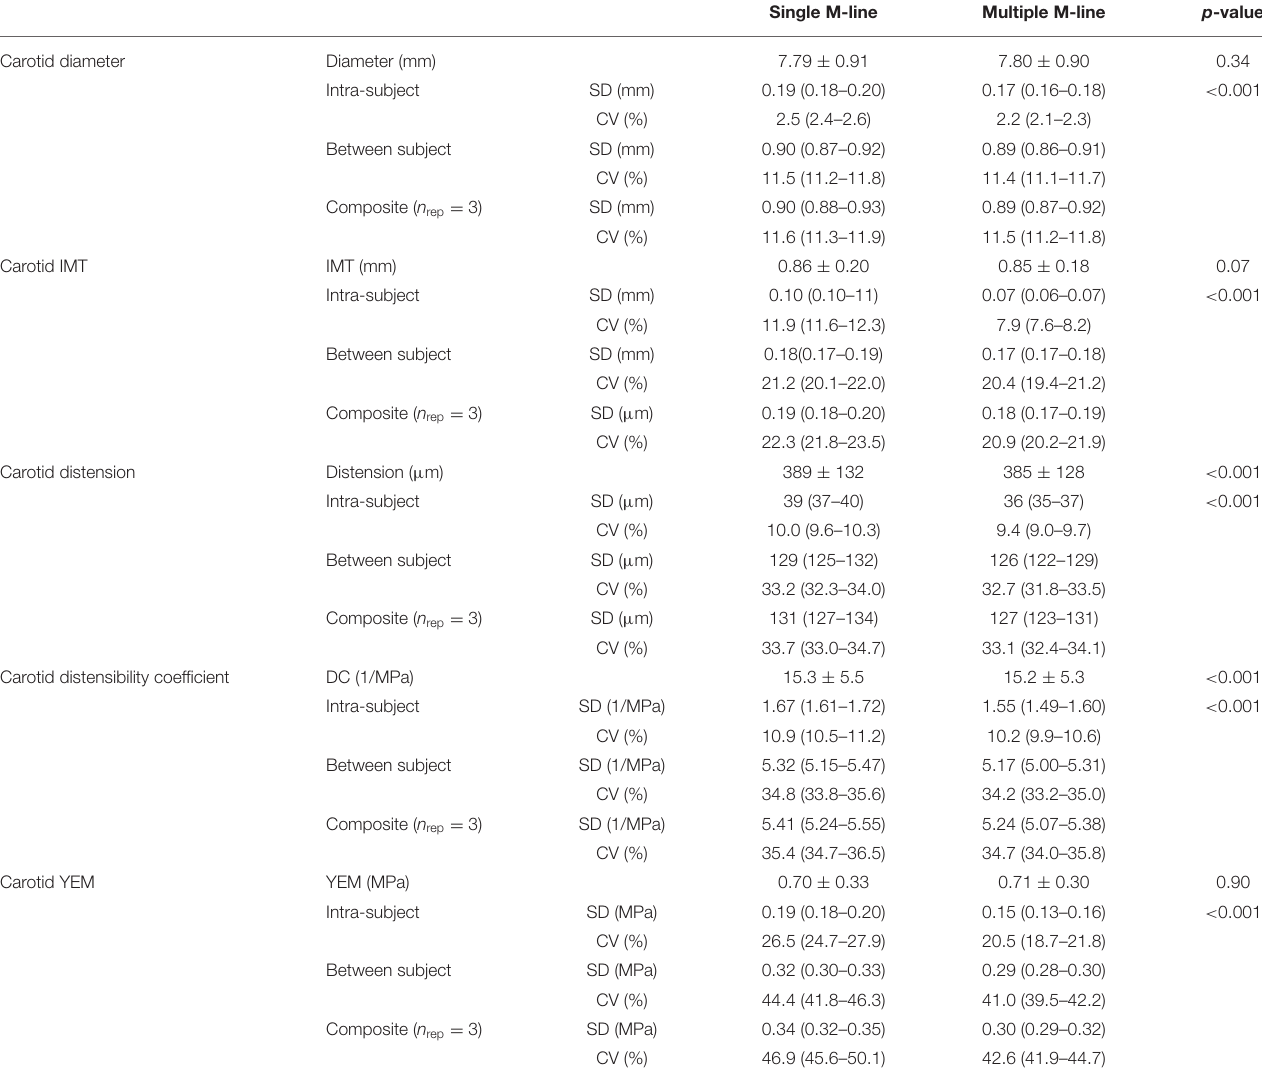
TABLE 2 | Common carotid artery properties as determined by single and multiple M-line